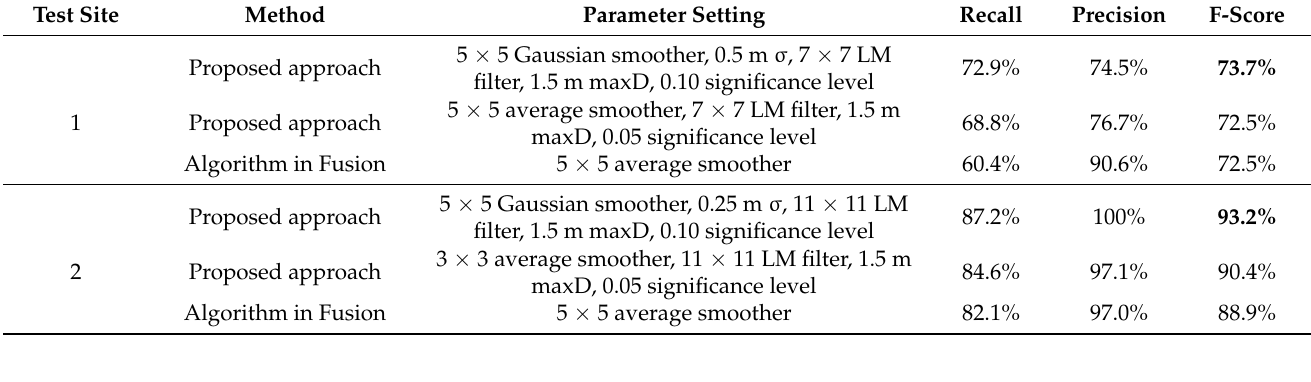
Table 4. Individual tree detection results derived by using the proposed approach and the algorithm in Fusion software. Test Site